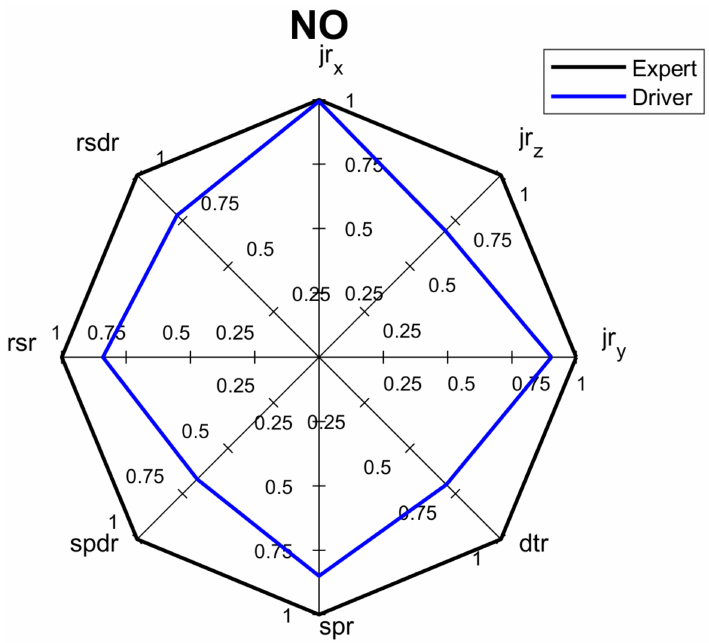
Figure 15. Spider diagram for overall score of long